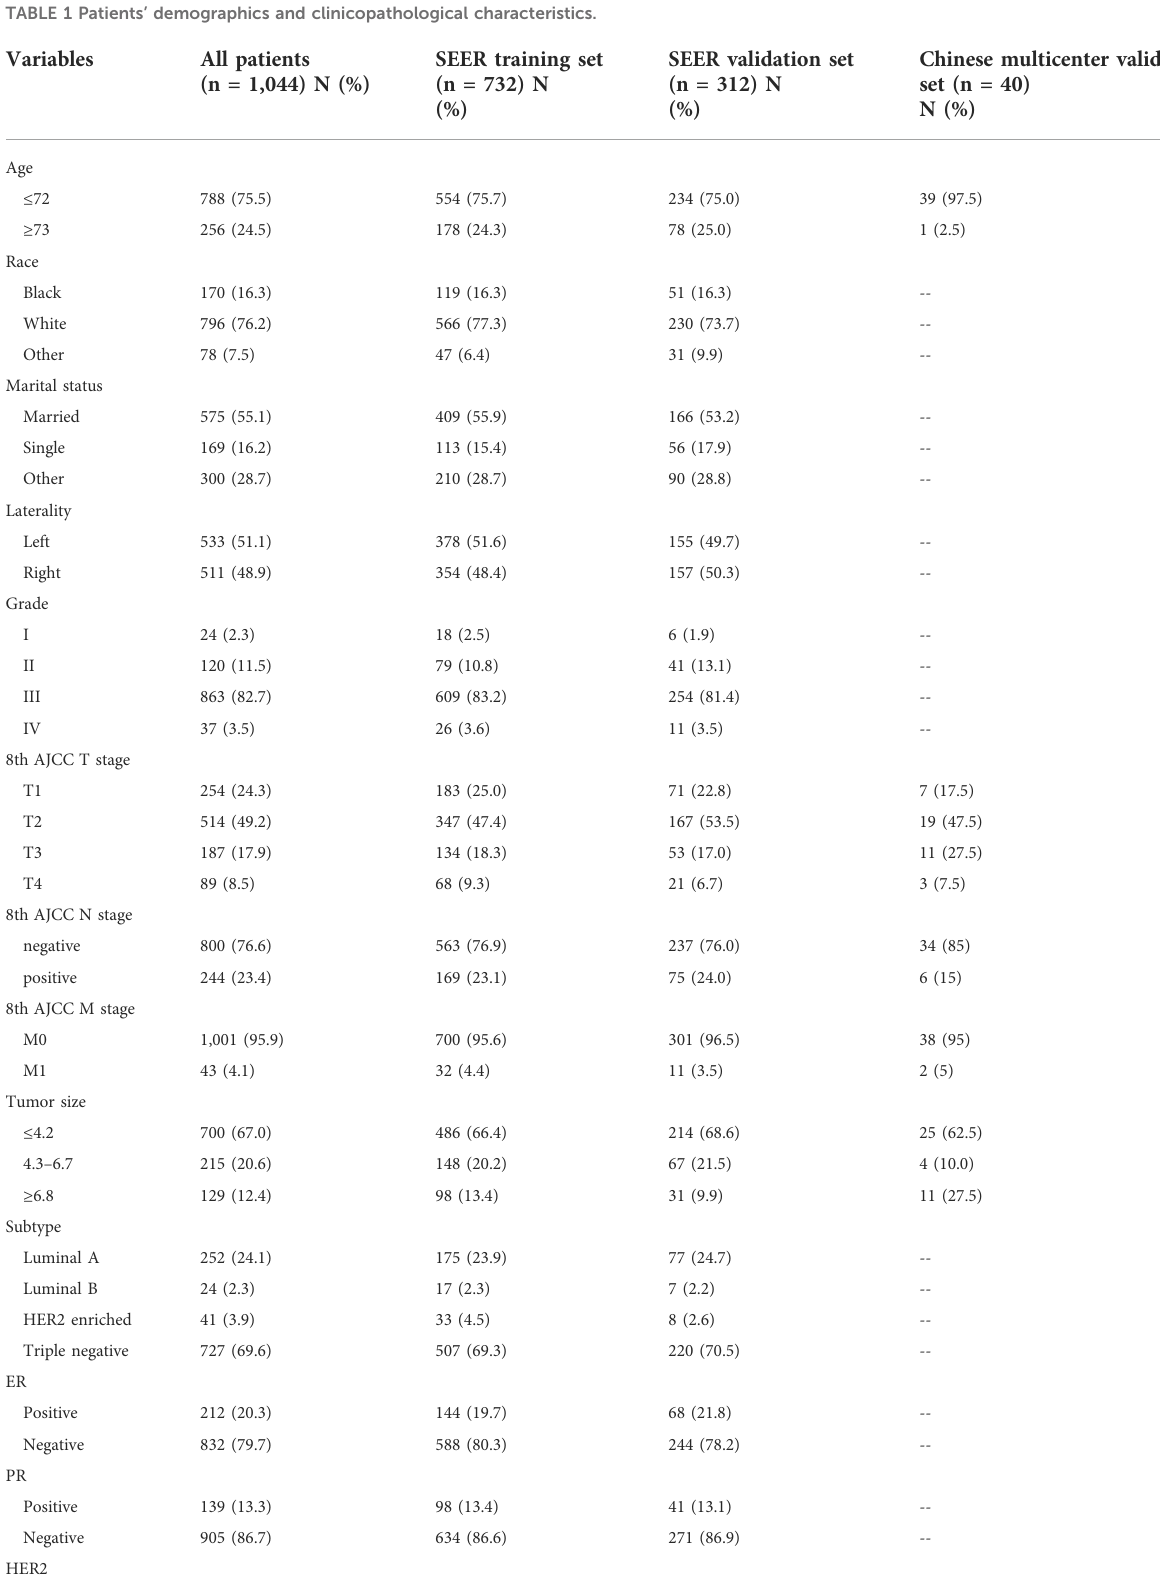
TABLE 1 Patients ’ demographics and clinicopathological